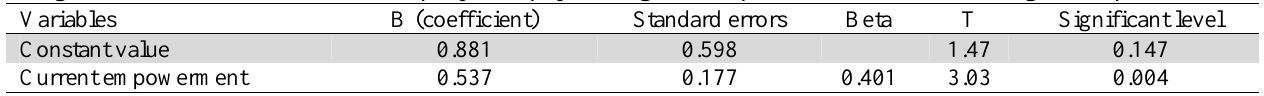
Regression model of effect of employee’s psychological empowerment on knowledge interpretation Variables B (coefficient) Standard errors Beta T Significant level Constant value 0.881 0.598 1.47 0.147 Current empowerment 0.537 0.177 0.401